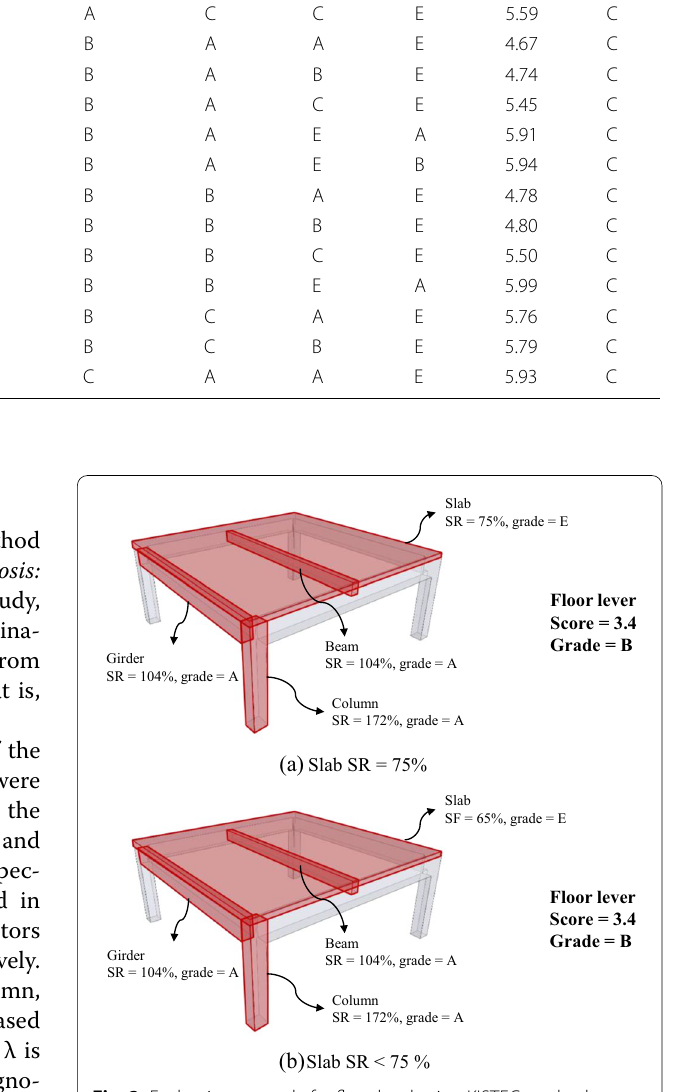
Table 4 Safety evaluation scores and grades from sample floors Member grade Floor level Column A A